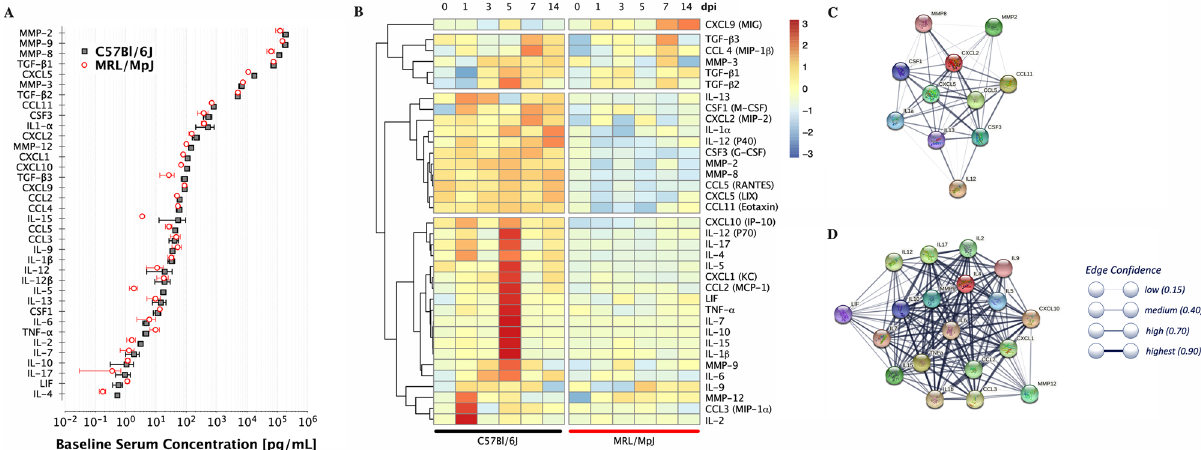
Figure 9. Serum protein analysis indicates temporal systemic upregulation of several circulating enzymes, cytokines, and chemokines in the C57 mice following tendon injury, but not in the MRL mice. ( A ) Baseline concentrations of serum proteins pre-injury plotted in order of concentration shows no significant differences between C57 and MRL mice. ( B ) Heatmaps for circulating serum enzymes, cytokines, and chemokines concentration (normalized to day 0 C57 controls) changes over time post flexor tendon injury (dark red indicates > + threefold increase and dark blue indicated > − threefold decrease compared to preinjury serum concentration). Dendrogram represent clustering based on Pearson’s correlations. Each box represents the average of N = 3 mice at each time point. String DB representation of physical and functional association network of cluster 3 ( C ) and cluster 4 ( D )